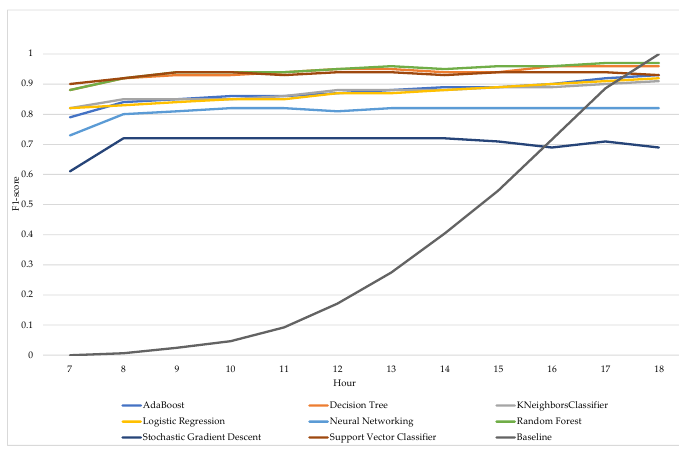
Figure 4. Average F1-Score per algorithm, per hour based on the individual scores. Sensors 2018 , 18 , 623